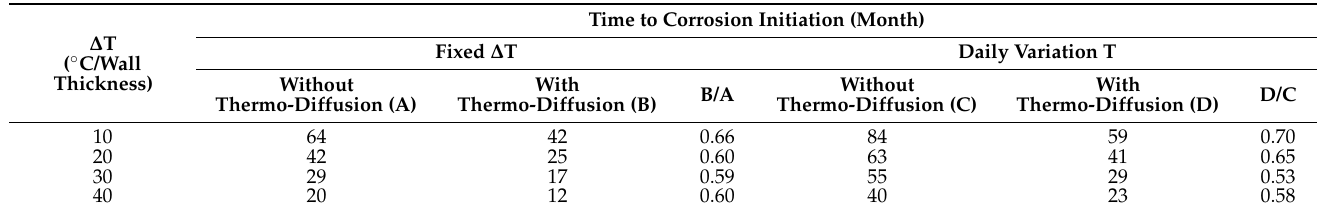
Table 4. Estimated time to corrosion initiation, calculated with/without consideration of thermo- diffusion effect for the different temperature gradients from 10 to 40 ◦ C/wall thickness with fixed external temperature ( A and B ) and with daily temperature variations ( C and D